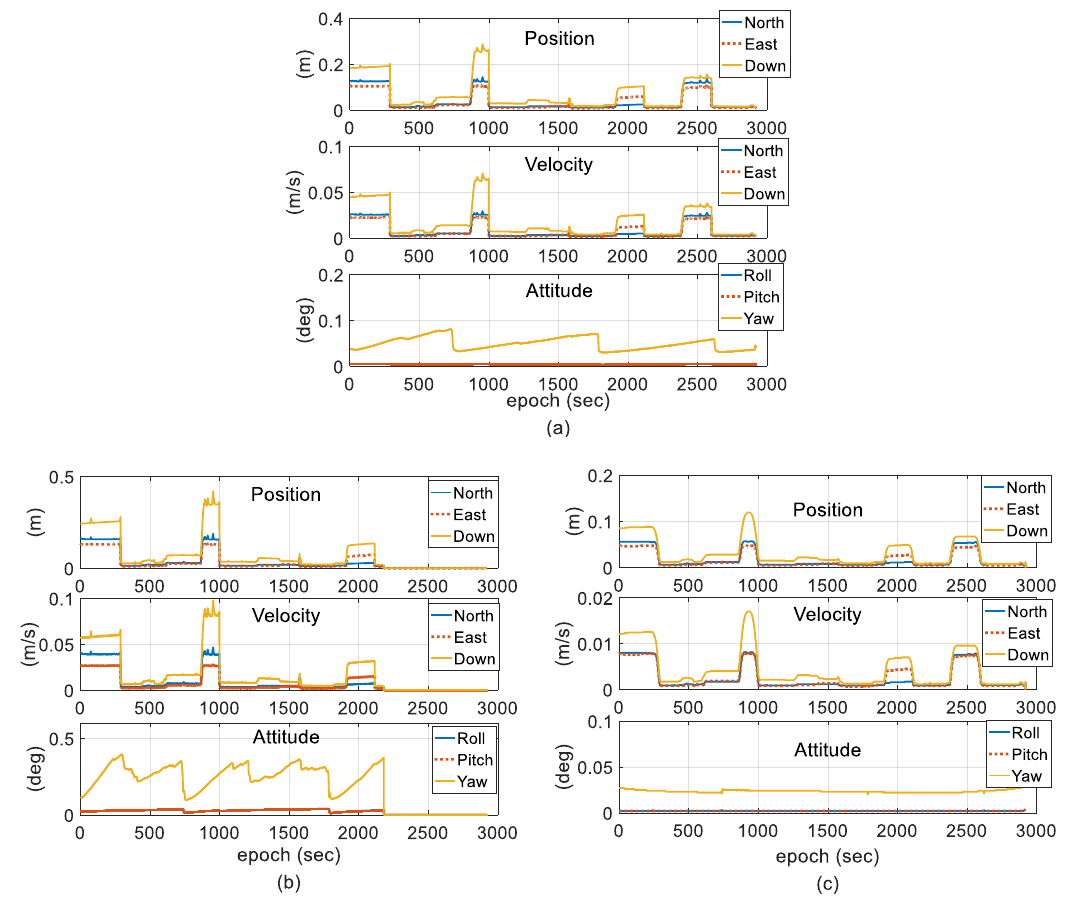
Figure 9. State estimate error for different schemes. ( a ) Scheme 1; ( b ) Scheme 2; and ( c ) Scheme 3.